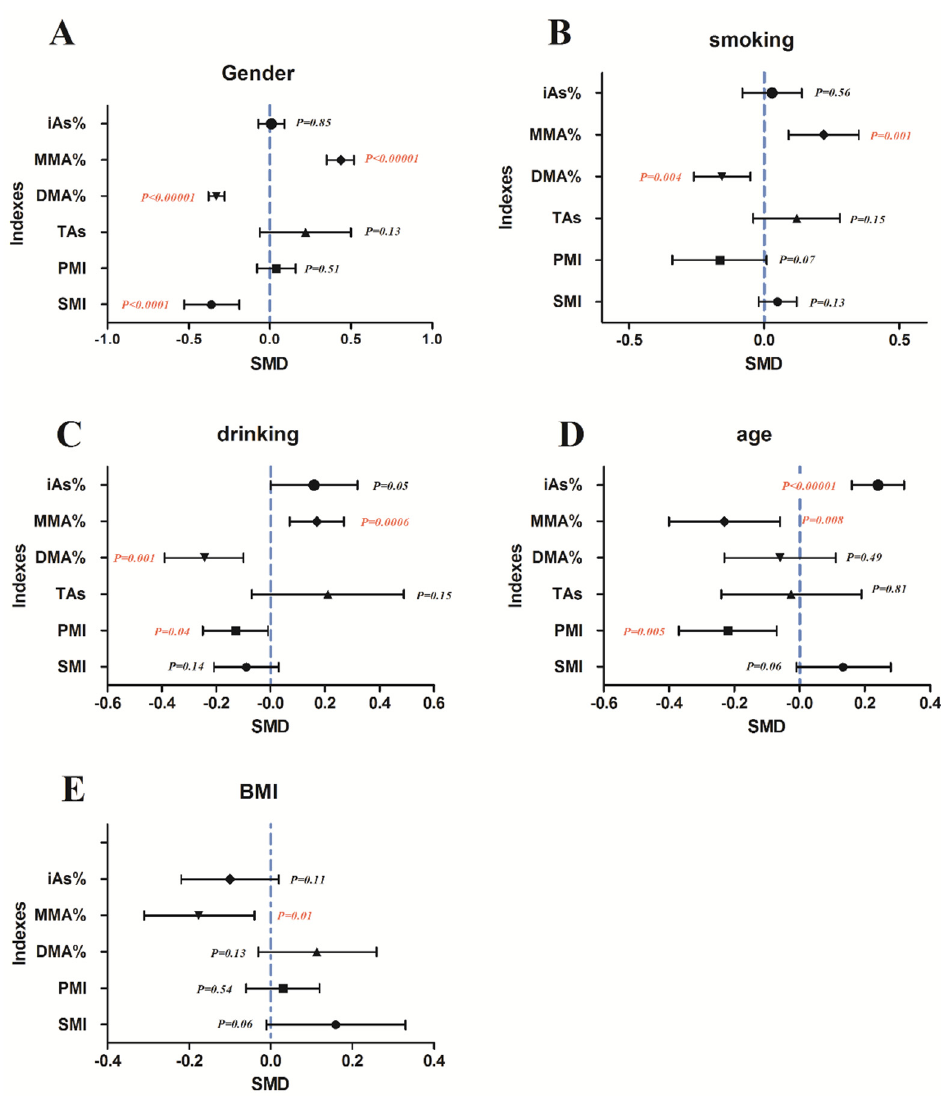
Figure 12. Effect of non-exposure factors on arsenic methylation (difference between ( A ) sexes, ( B ) smoking; ( C ) alcohol; ( D ) age; and ( E ) body mass index (BMI) on the arsenic methylation indexes, including the percentage of inorganic arsenic (iAs%), percentage of monomethyl arsenic (MMA%), percentage of dimethyl arsenic (DMA%), total arsenic (TAs), primary methylation index (PMI), and secondary methylation index (SMI). SMD, standardized mean difference